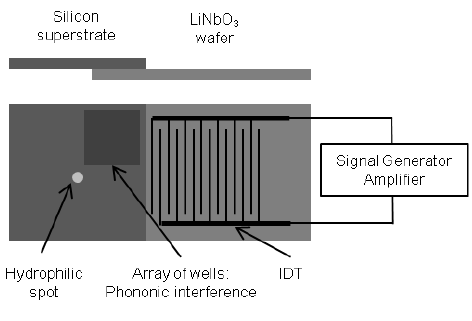
FIGURE 1: The set-up for the SAW experiments.